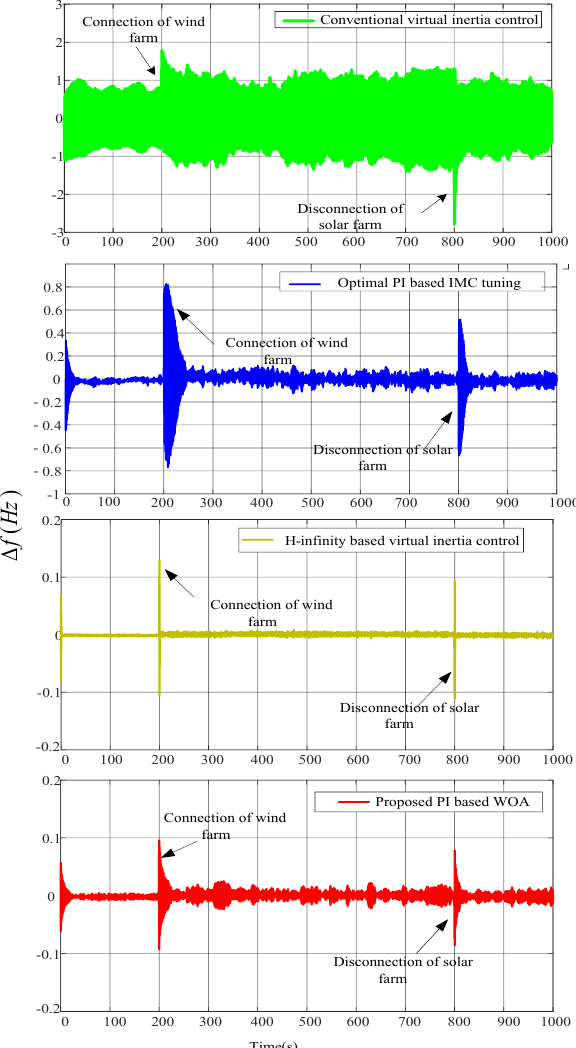
Figure 11. Frequency response in case of primary controller